Question: Express in one sentence what the figure is showing.
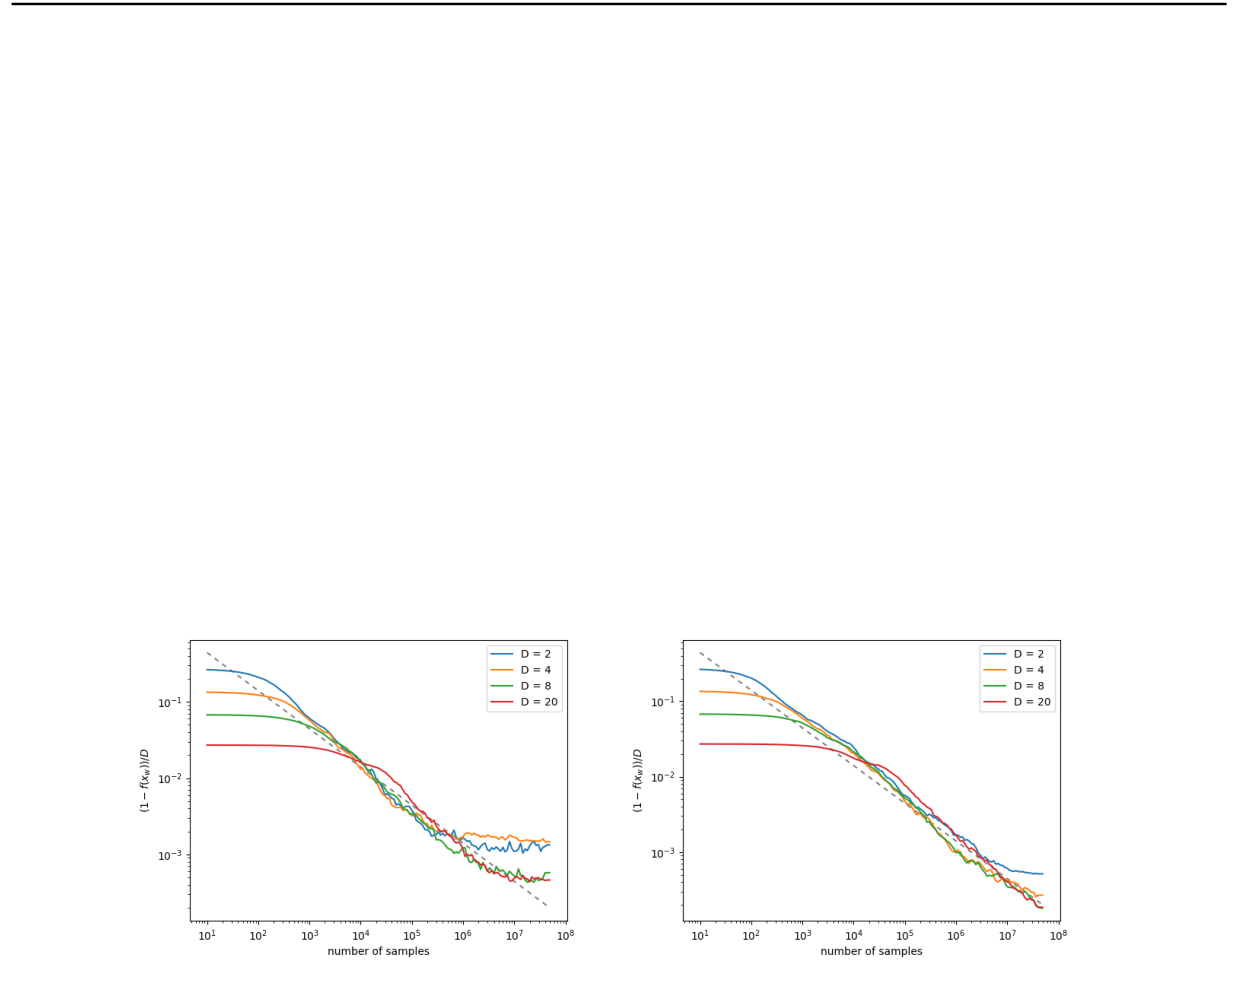
Answer: Normalized error, ϵ/D, of algorithm 2 as a function of the number of samples (ns) for different dimensions. The dotted gray line represents the function c/n1/2 s with c = 1.4. Left: algorithm parameter κ = 0.5 , right κ = 1.0. Error is averaged over 5 runs for each trace. Fitness function is defined as f(x) = 1 −1